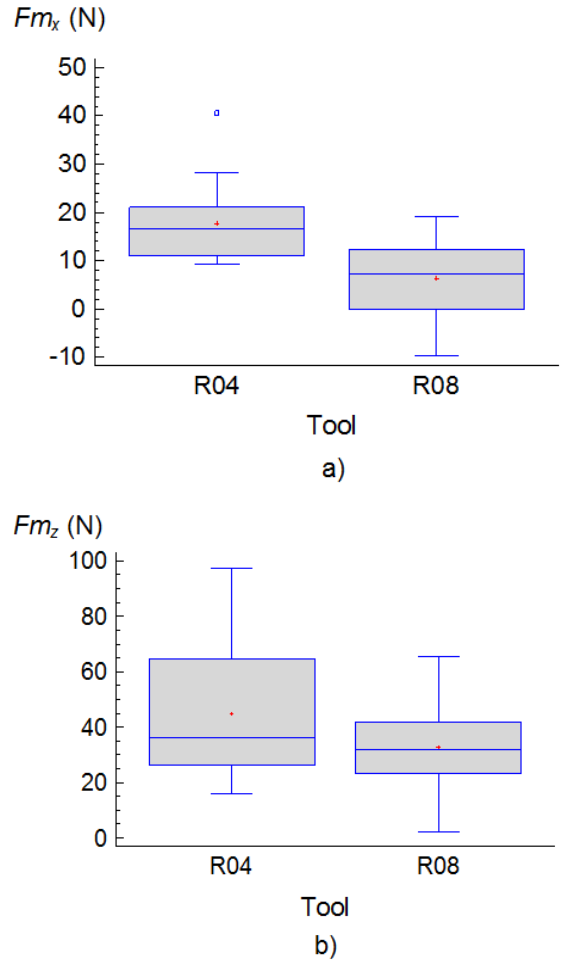
and ( b ) Fm versus the type of tool x z